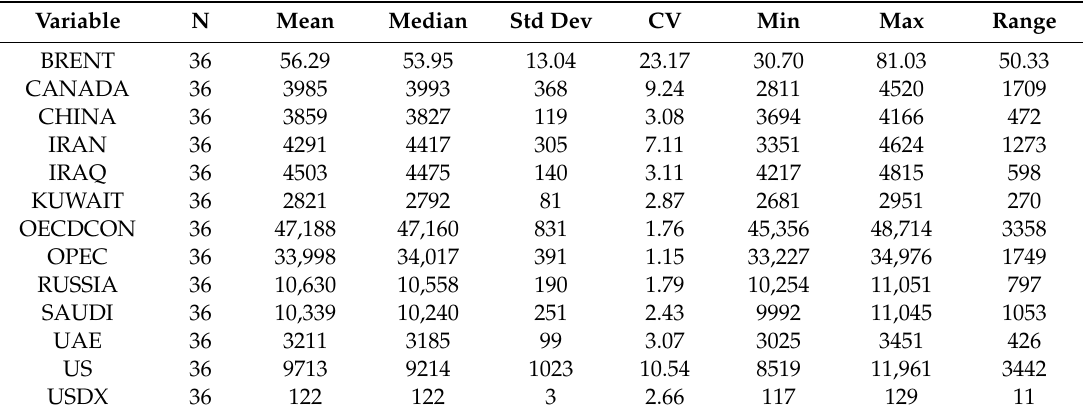
Table 17. Panel 7 period (2016–2018): summary statistics.